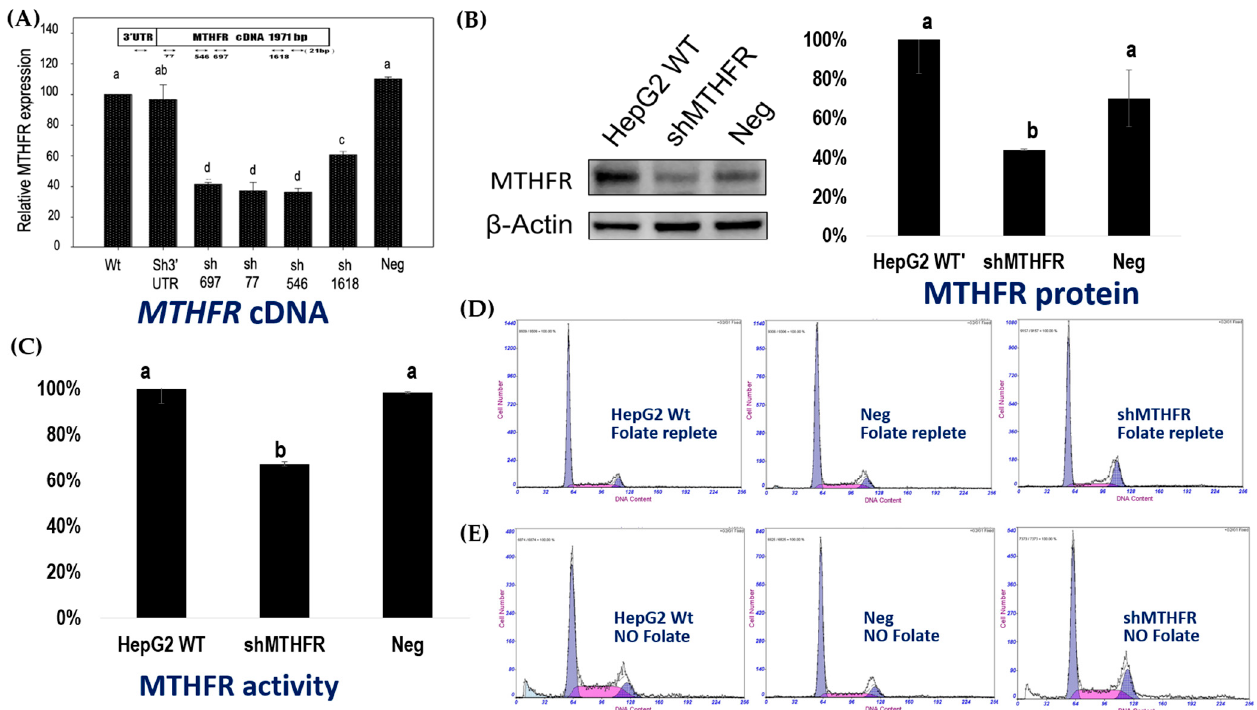
Figure 2. Stabilized inhibition of MTHFR in HepG2 cells using RNAi delivered by lentiviral vector. ( A ) Five different homologous human shRNA target sequences were designed for human MTHFR gene in order to study the impacts of MTHFR gene silencing. These RNAi lentivirus clones are termed sh3 ′ UTR, sh77, sh546, sh697, sh1618 that represented the target site on the MTHFR cDNA sequence (see Supplemental Data File for Figure S1). The shGFP clone was used as the negative control cell-line (Neg). Among them, clone sh77 had a significant reduction (by ~63%) in MTHFR mRNA expression and was chosen to represent the shMTHFR cell line for further studies. ( B ) shMTHFR (sh77) had reduced MTHFR protein expression compared to WT and Neg cells. Data are shown as mean with SE for triplicate samples. Different letters indicate statistical differences ( p < 0.05) among different groups calculated by one-way ANOVA). ( C ) shMTHFR (sh77) cells had reduced MTHFR enzyme activity compared to WT and Neg cells. MTHFR enzyme activity was determined by radioisotope analysis described in the Materials and Methods section. Data are shown as mean ± SE for triplicate samples. Different letters indicate statistical differences ( p < 0.05) among different groups calculated by one-way ANOVA). ( D ) shMTHFR significantly decreased cell populations in the G1 and S phases and increased that in the G2/M phase in adequate folate. The quantitative data for flow cytometry are shown in Table 1B. ( E ) The impacts of MTHFR and folate depletion on cell cycle distributions. The quantitative data for flow cytometry are shown in Table 1B. The original flow cytometry data presented in Table 1B can be found in Supplemental Figure